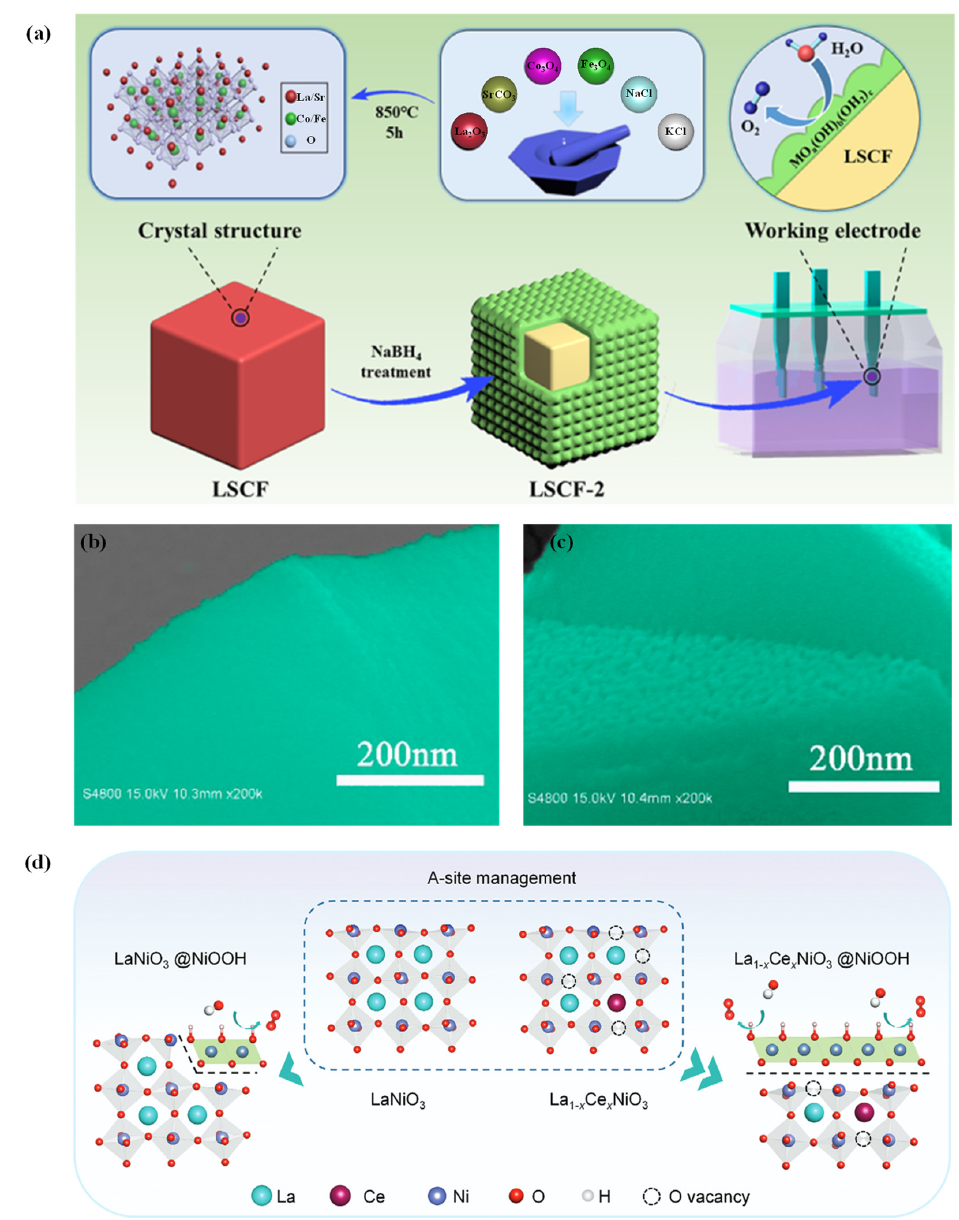
Figure 10. ( a ) A schematic that illustrates the surface reconstruction over the LSCF-0 surface. SEM images of ( b ) LSCF-0 and ( c ) LSCF-2. Reproduced with permission from ref. [135], Copyright 2019, American Chemical Society. ( d ) The surface reconstruction process of La 1 − x Ce x NiO 3 to the active structure of NiOOH by the A-site management of the Ce substitution strategy. Reproduced with permission from ref. [136], Copyright 2021, Wiley.